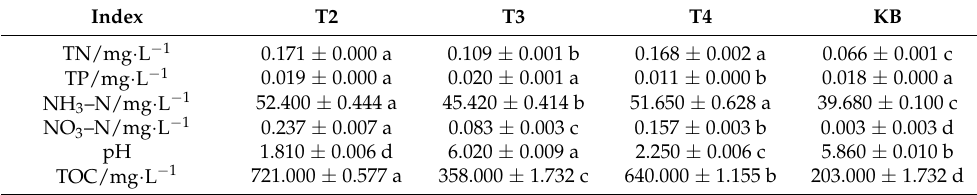
Table 2. Physicochemical properties of bistriazine ring derivative wastewater after degradation.